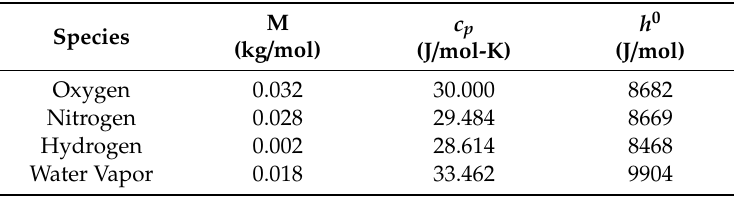
Table 1. Gas properties at 298 K